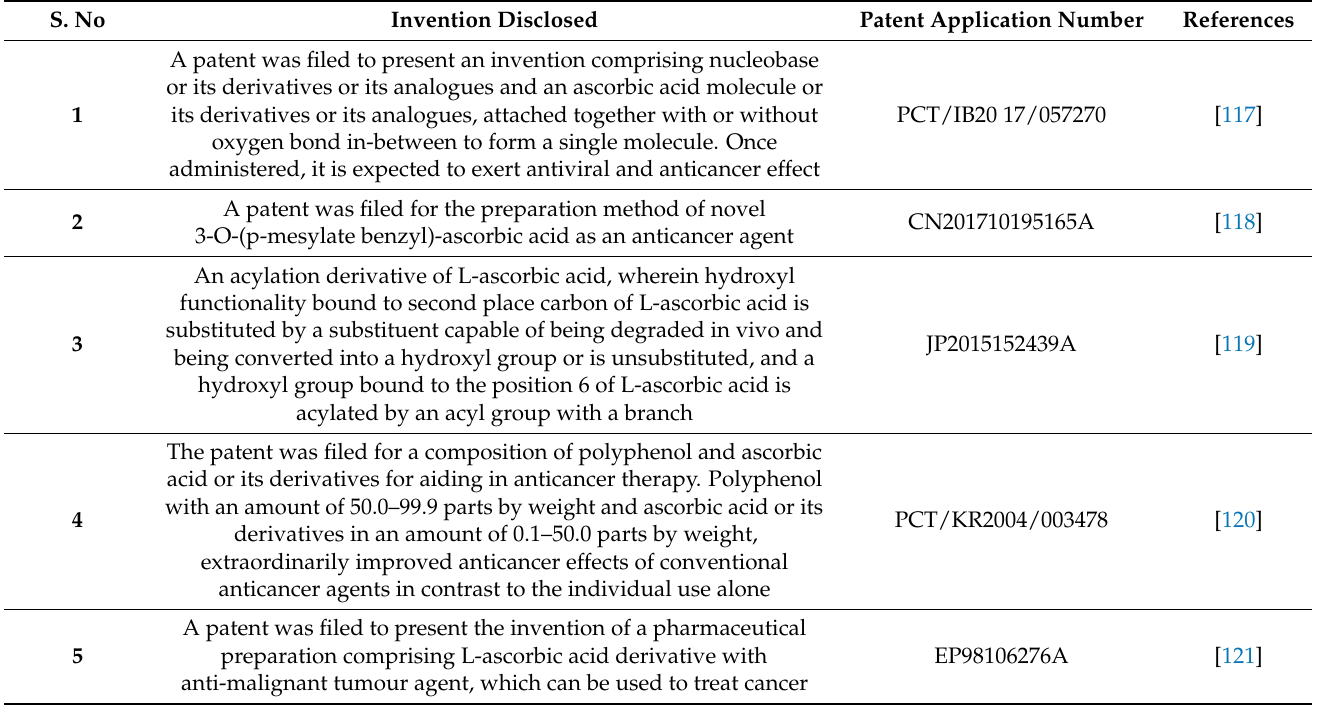
Table 1. List of some patents related to anticancer activity of ascorbic acid and its derivatives. S.